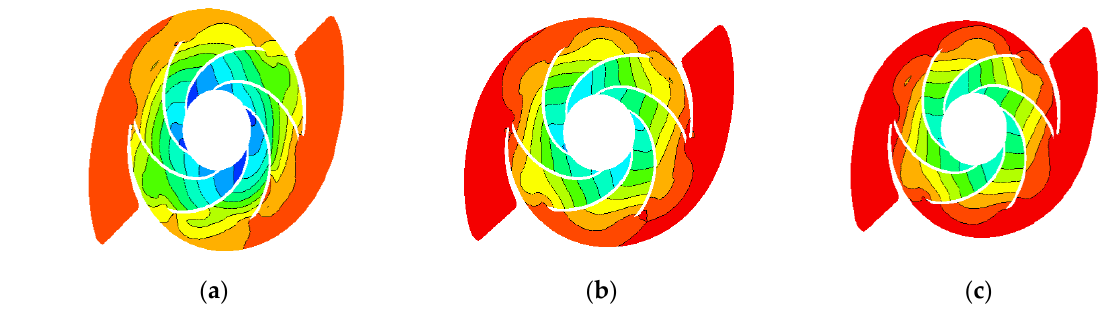
Figure 13. Static pressure distribution in the mid-section of the positive passage at three typical flow rate conditions. ( a ) 0.6 Q , ( b ) 1.0 Q , ( c ) 1.1 Q .